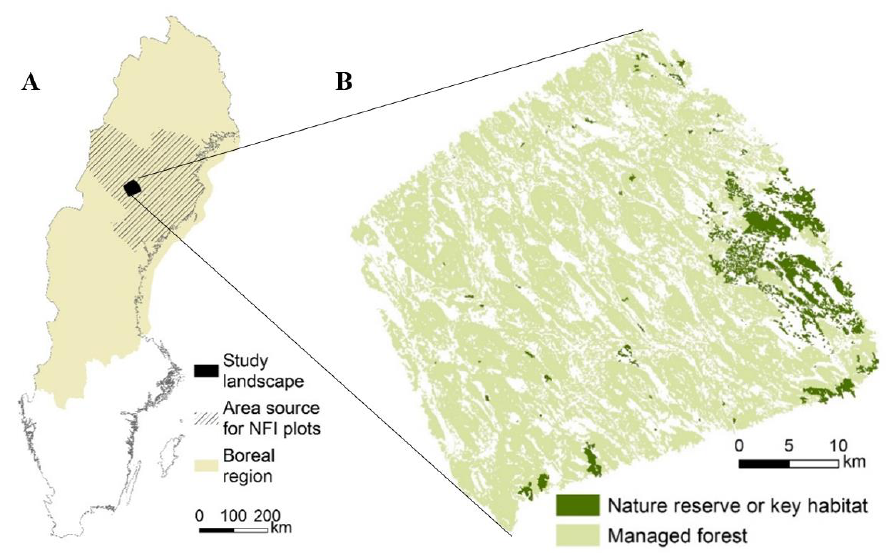
Figure 1. The study landscape is located in the middle of the boreal region in Sweden ( A ). Most of the study landscape is covered by productive forest, of which 7.8% is permanently set aside from forestry (nature reserves and key habitats) ( B ).